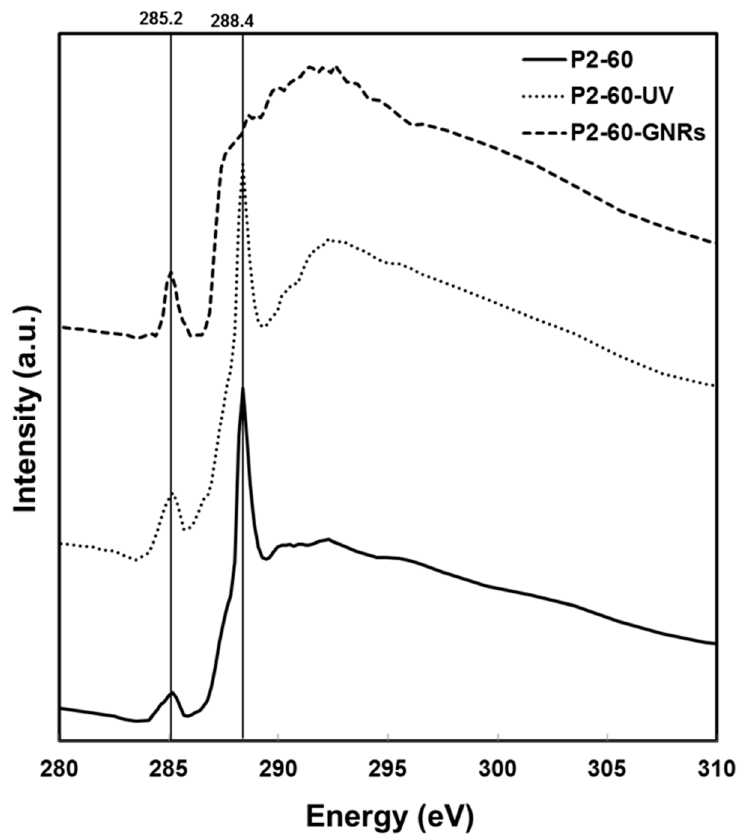
Figure 7. NEXAFS spectra of C1s K-edge for Au–PMMA with higher M w and 60% concentration in three stages of the GNRs formation, [P2-60] mixture of gold salt with PMMA polymer, [P2-60-UV] formation of Au–PMMA nanocomposite with 60 wt % gold using UV photoreduction, and [P2-60-GNRs] formed GNRs with seed mediated method over surface of P2-60 nanocomposite.